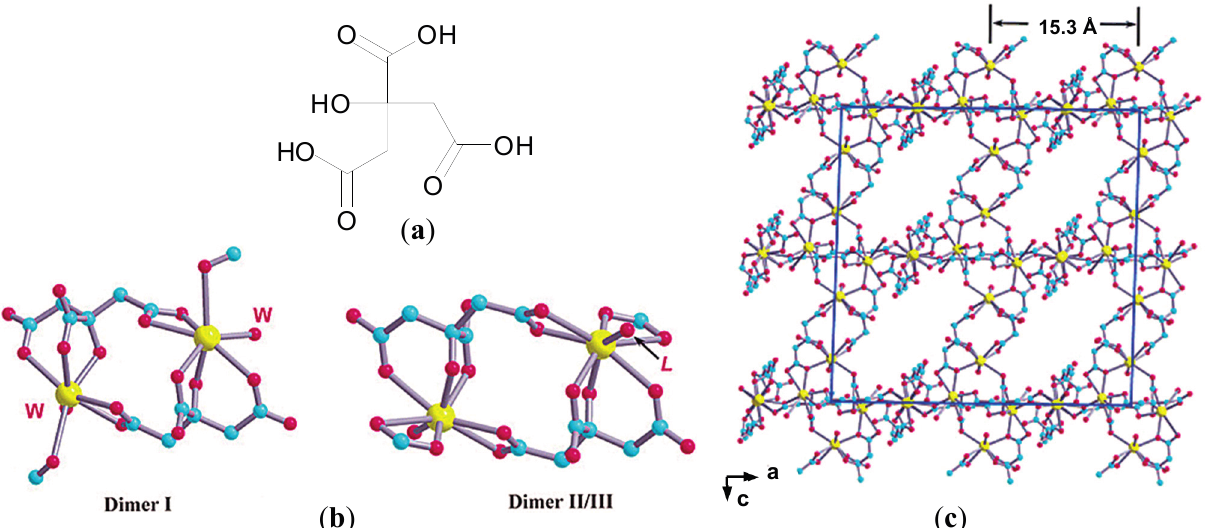
Figure 6. ( a ) Structure of citric acid; ( b ) Basic dimeric units [Bi(cit) 2 Bi] 2 − found in K(NH 4 )[Bi 2 (cit) 2 (H 2 O) 2 ].4H 2 O with a C2 symmetry (dimer I) and an inversion center